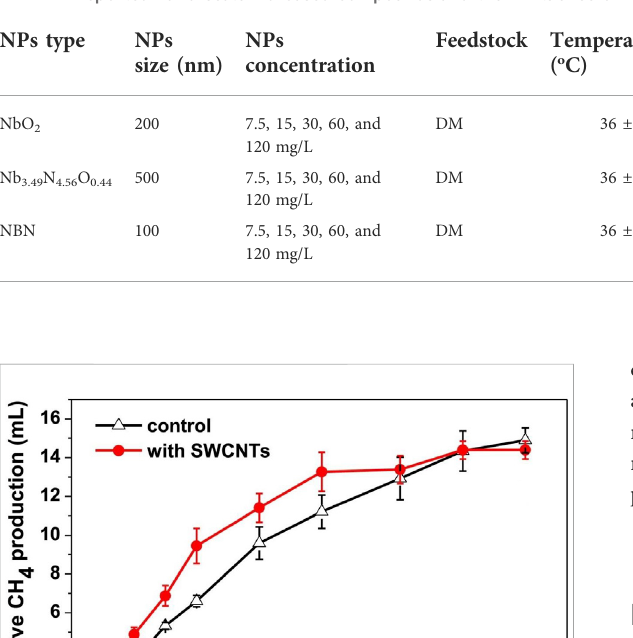
TABLE 4 Reported nano-scale Nb-based compounds and their in fl uence on biogas generation.